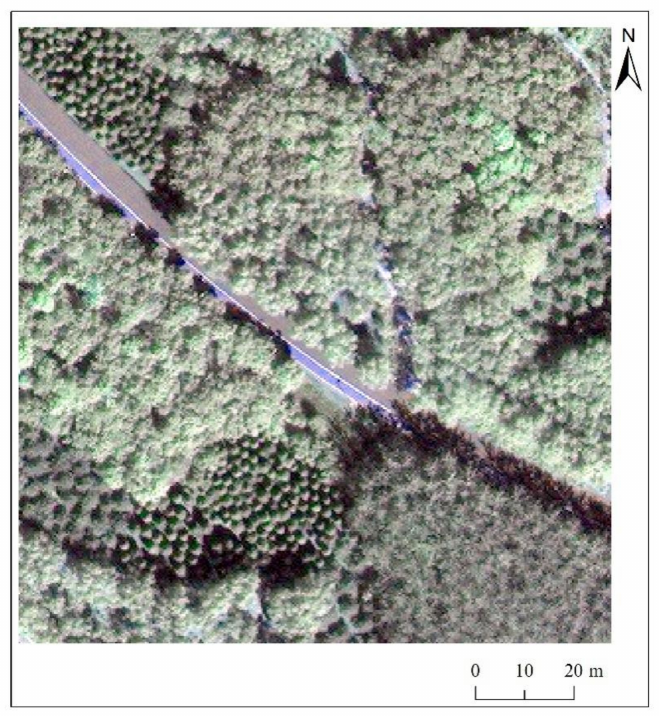
Figure 7. The test image used for the accuracy